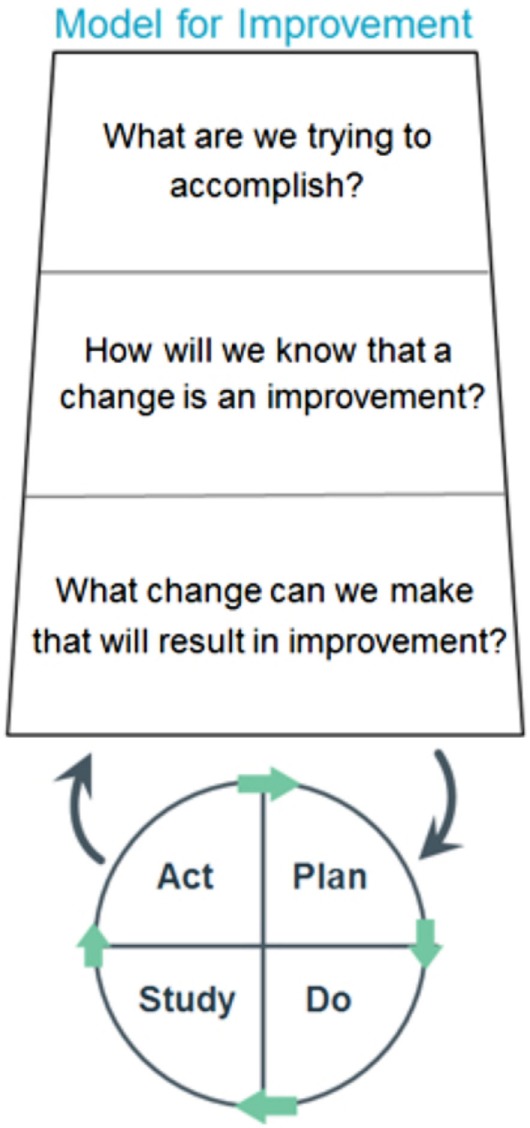
PDSA model for improvement (13).